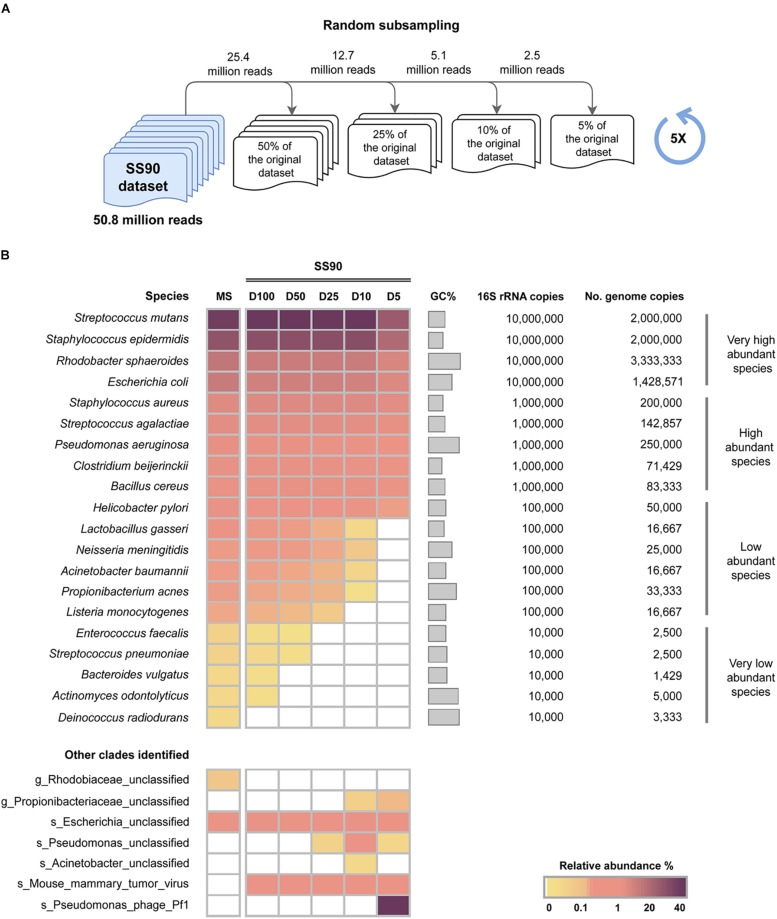
Impact of sequencing depth on the sensitivity of WMS for microbiome taxonomic profiling. (A) Schematic representation of the experimental design to generate random subsampling reads from the SS90 original dataset (90% host DNA). Random subsampling corresponding to 50, 25, 10, and 5% of the reads from the original dataset (SS90D50, SS90D25, SS90D10, and SS90D5, respectively) were generated. (B) Taxonomic profile of the generated datasets are represented as the average relative abundance from five independent experiments, and shown in a heat map. Data was sorted from the highest to the lowest relative abundances of species in the mock microbial community (MS).